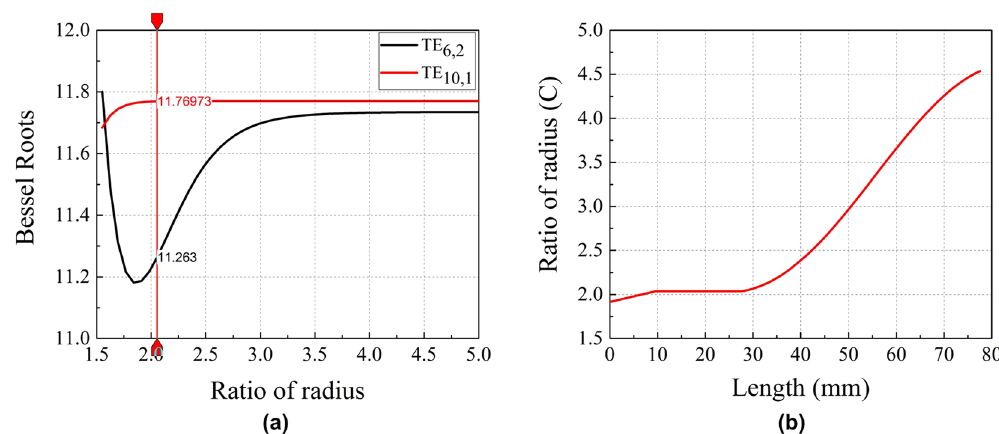
Figure 5. ( a ) Effective Bessel roots versus the ratio C of the cavity radius to the inner rod radius for the mode pair TE 6,2 and TE 10,1 . The vertical line indicates the radii ratio at the center of the cavity. ( b ) C along the length of the